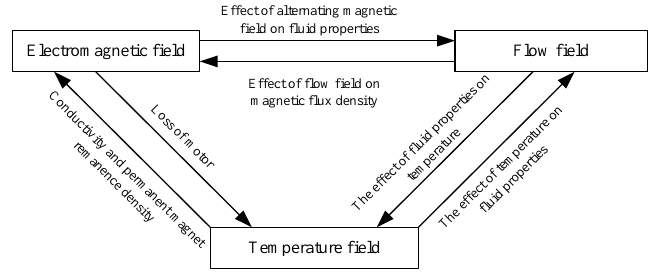
Figure 2. Schematic diagram of three-field coupling relationship.